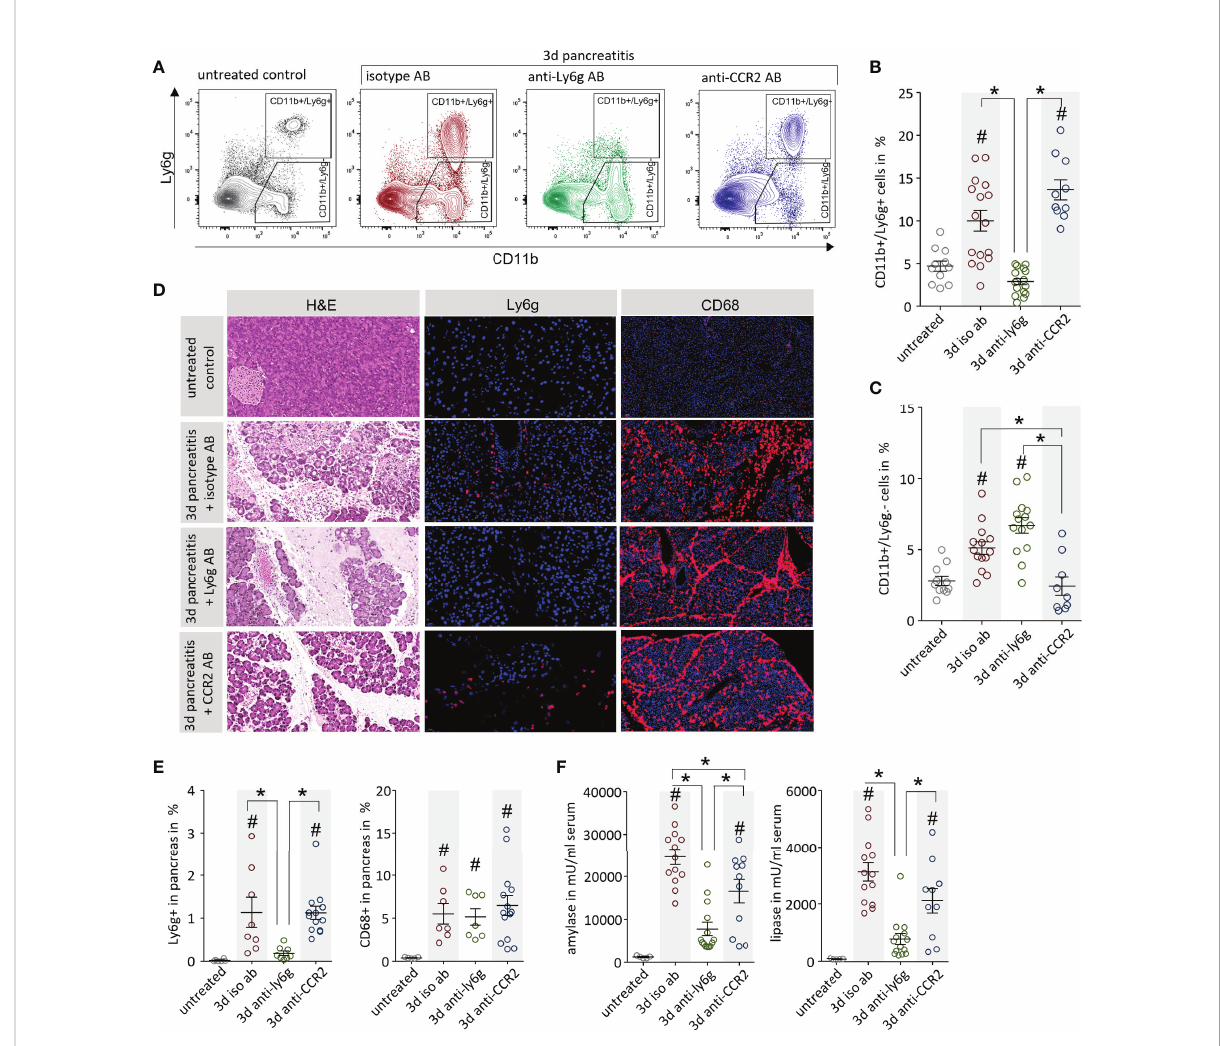
FIGURE 5 Leukocyte depletion ameliorates pancreatitis in mice. (A) The ef fi ciency of the leukocyte depletion was proven by fl ow cytometry analysis of splenocytes with the surface markers CD11b and Ly6g to distinguish neutrophils (CD11b + /Ly6g + ) and monocytes (CD11b + /Ly6g - ). (B) An increase of CD11b + /Ly6g + neutrophils could be observed after onset of disease in isotype and anti-CCR2 treated mice, but not after anti-Ly6g antibody treatment. (C) In contrast, the number of CD11b + /Ly6g - cells was increased during pancreatitis but not in the anti-CCR2 antibody treated group. (D) Pancreas histology showed development of necrosis in all pancreatitis animals except in untreated controls. Immuno fl uorescent Ly6g-labelling showed the absence of Ly6g + neutrophils in pancreatic tissue of anti-Ly6g treated mice. Labelling by anti-CD68 showed a dramatic increase of macrophages in the pancreatic tissue of all mice with pancreatitis, even after the depletion of monocytes by anti-CCR2 treatment. (E) Quantitative evaluation of Ly6g + and CD68 + cells in immuno fl uorescence-labelled pancreatic sections (F) Serum amylase and lipase activity re fl ected disease severity and showed a reduction a dramatic in the anti-Ly6g treated mice and a slight decrease in the anti-CCR2 treated animals. All graphs represent 6 or more animals each group. A statistical signi fi cant differences was tested by one way ANOVA followed by Tukey ’ s multiple comparison test, or by Kruskal-Wallis test followed by Dunn ’